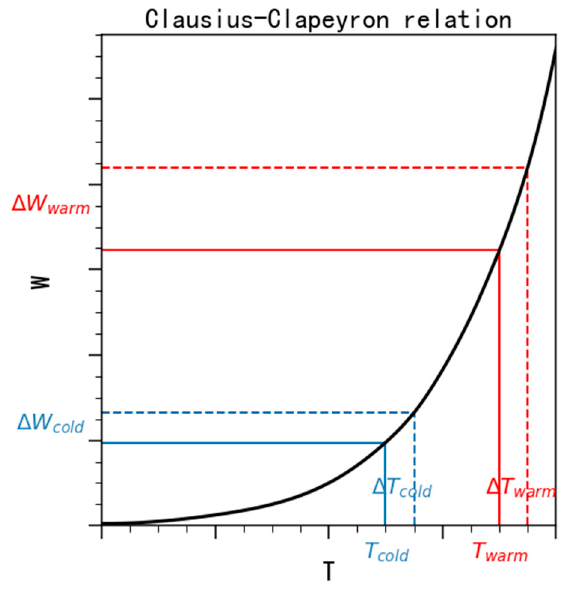
Figure 9. Sketch map of Clausius–Clapeyron relation between precipitation water and air tempera- ture.